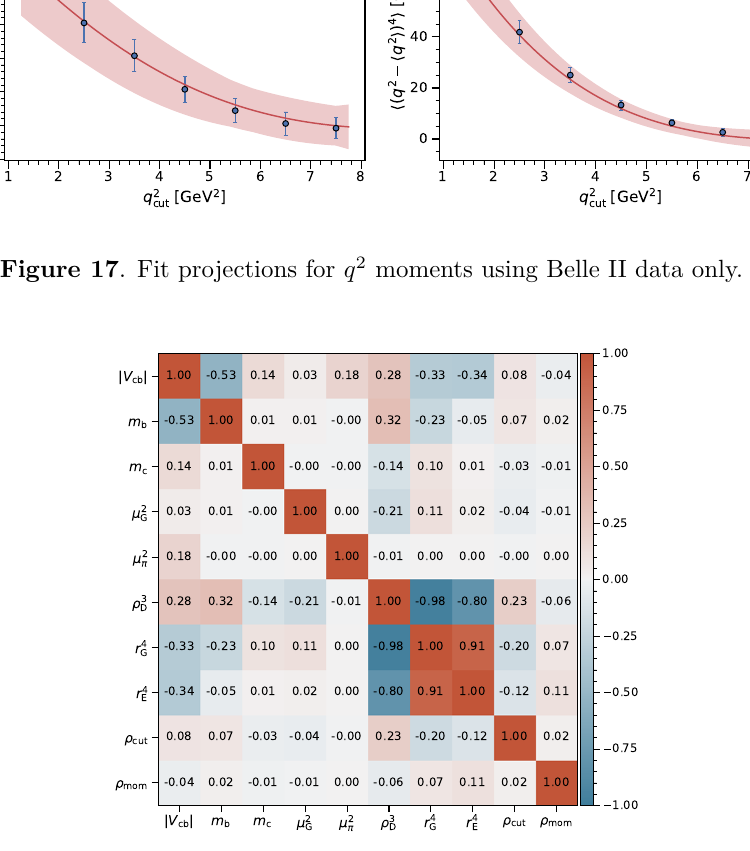
Figure 18 . Correlation matrix for | V cb | , the HQE parameters, and the correlation parameters ρ mom and ρ using Belle II data cut